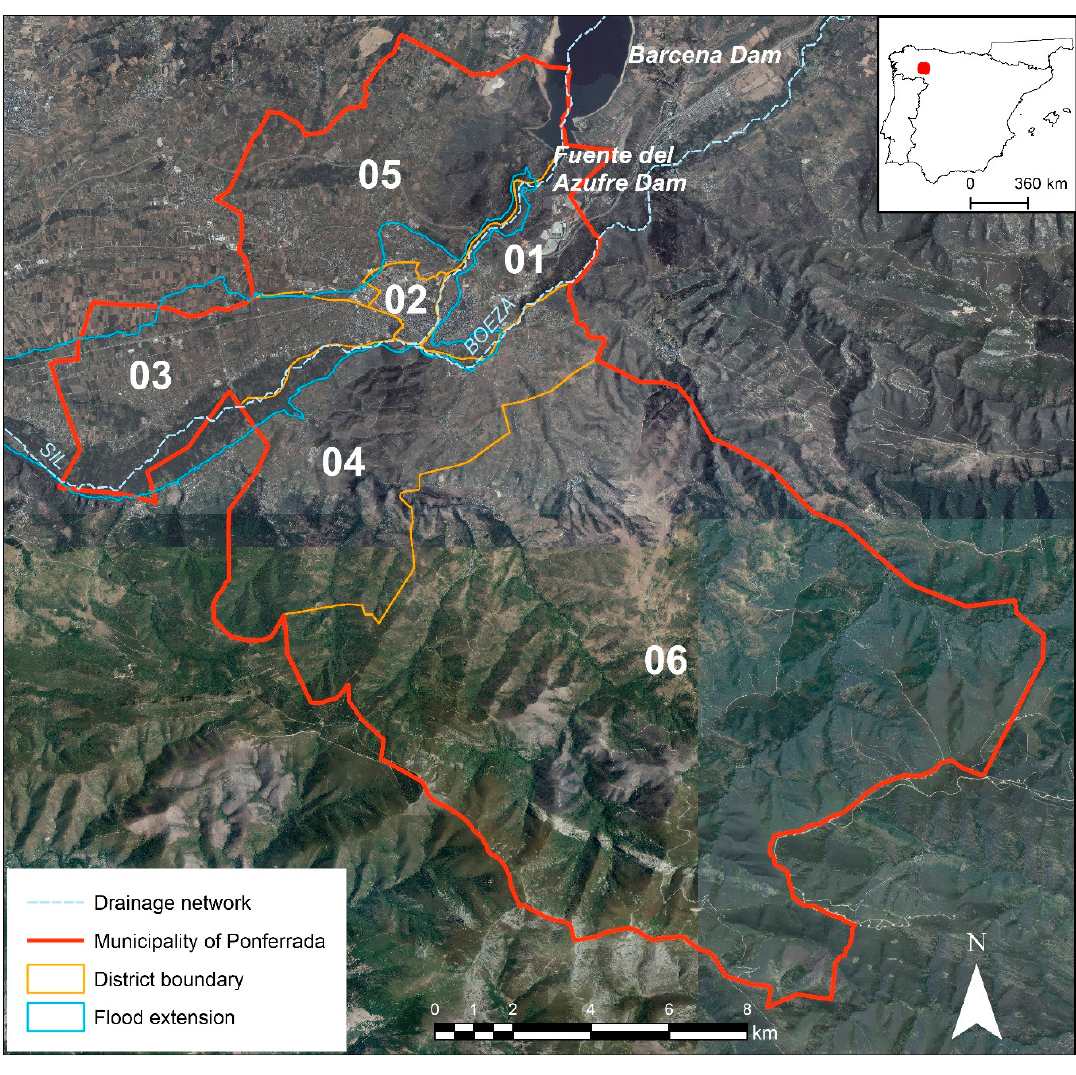
Figure 1. Location of the study area.